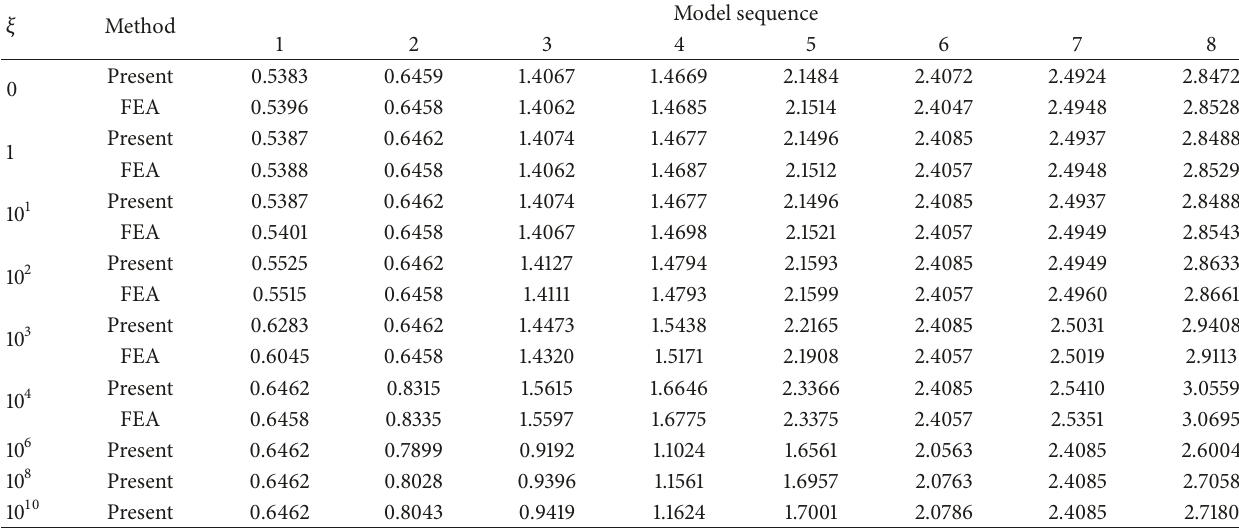
= 𝜉 = 𝜉 , 𝜉 = 0 , for 𝐾 𝑖 𝐾 𝑖𝑗 𝑖